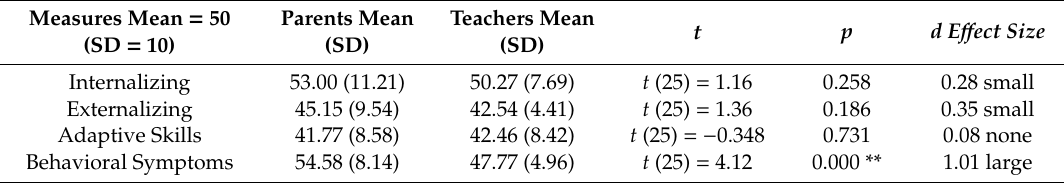
Table 1. Paired t -test for Behavior Assessment System for Children (BASC) Composite Scales with Raters for 26 children with Selective Mutism (SM). SD; Standard